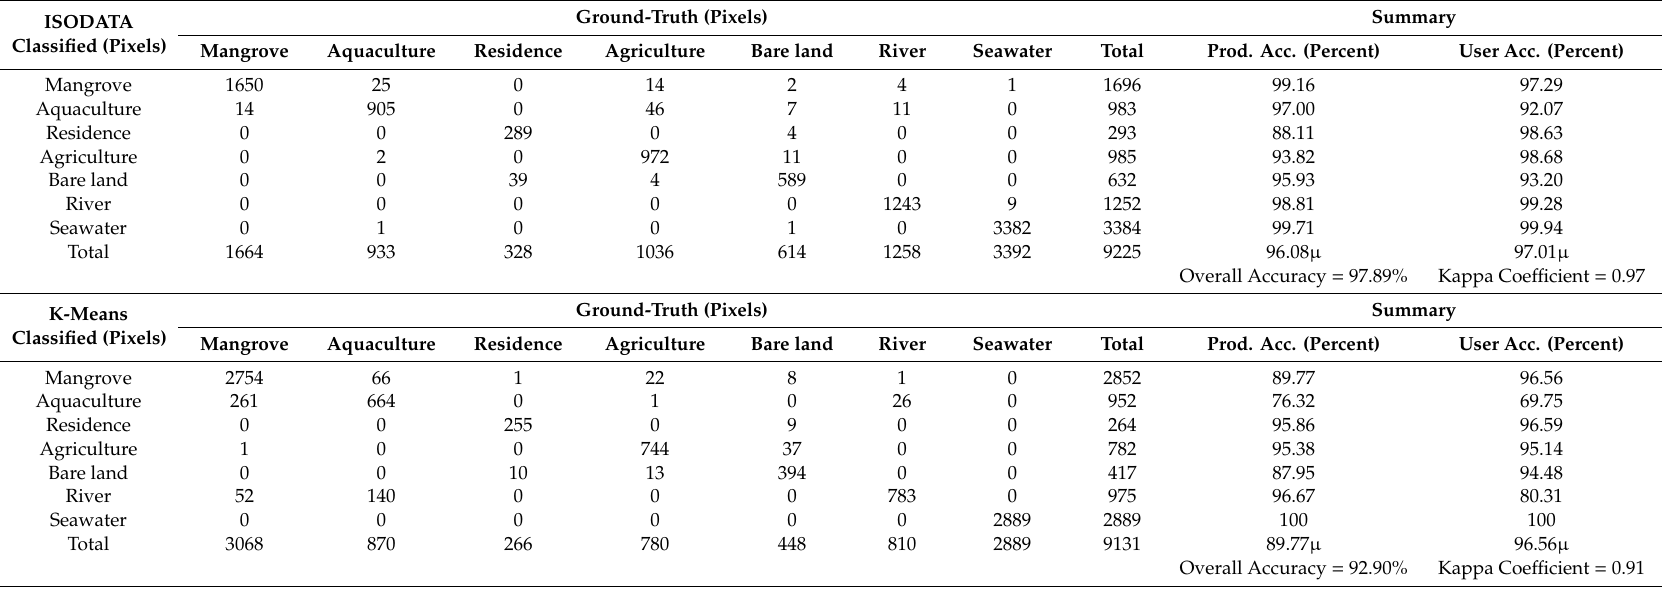
Table 5. Confusion matrices and accuracy indexes created for the unsupervised ISODATA and K-means classifiers using Landsat 8 acquired in 2019; Prod. Acc. and User. Acc. are short forms of producer and user accuracy; µ presents the averaged